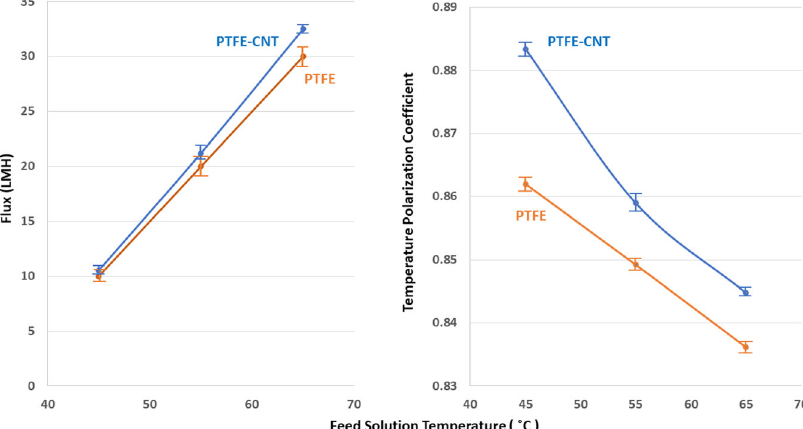
Fig. 3 Water permeate fl ux and TPC values during a 24-h DCMD test using PTFE and PTFE-CNT membranes at a constant coolant temperature of 15